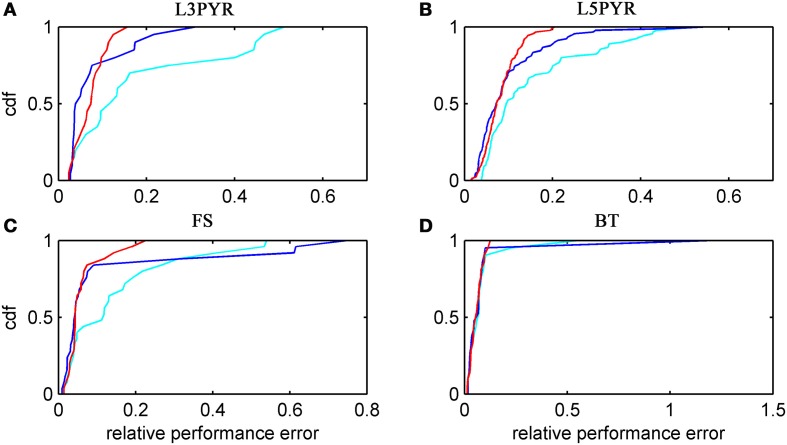
Relative prediction error for a large physiological data pool from different neuron types recorded in-vitro. For the 4 neuron types (A: layer-3 pyramidal cell, B: layer-5 pyramidal neuron, C: fast-spiking and D: bitufted interneuron), the empirical cumulative distribution of the relative prediction error (Equation 32) is shown (ν0: cyan, ν0 + ϵ2 ν2: blue, 〈 νEIF 〉w: red). Relative prediction error averaged over σIsyn = (100, 300) pA and μIsyn = [r − 15, r − 10, r − 5, r, r + 5, r + 10, r + 15] pA with r denoting the cell-specific rheobase. N(L3) = 20, N(L5) = 90, N(FS) = 25, and N(BT) = 21.